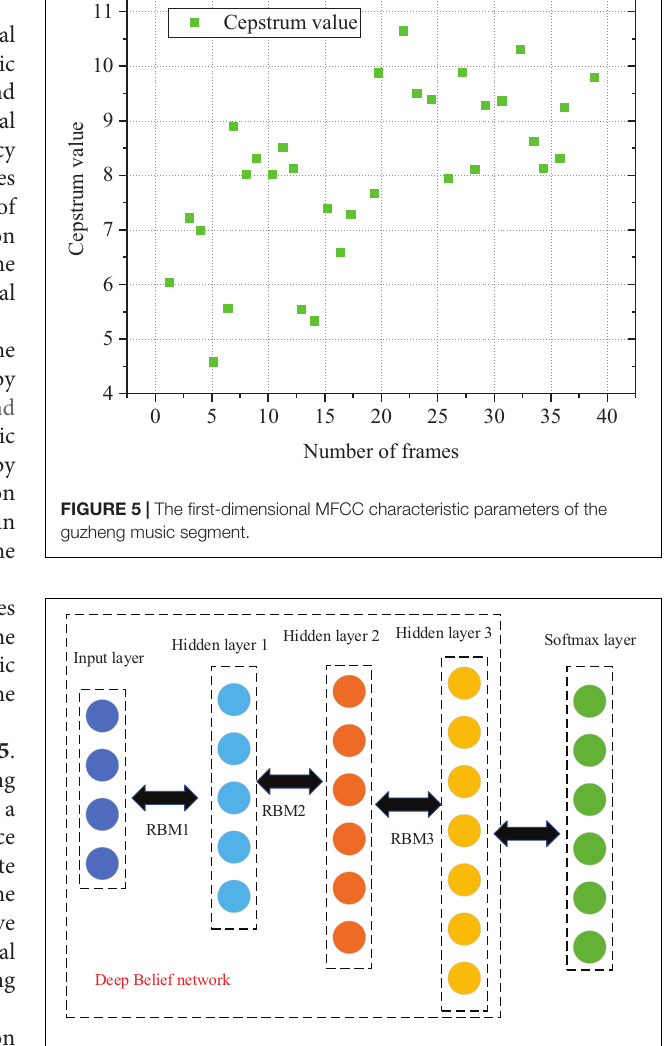
FIGURE 6 | The DBN-based structure of the national musical instrument recognition and differentiation